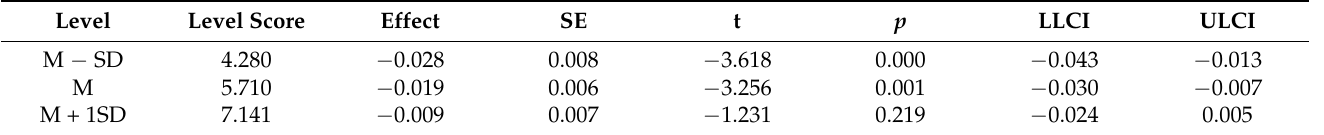
Table 3. Direct effects of different household SES.